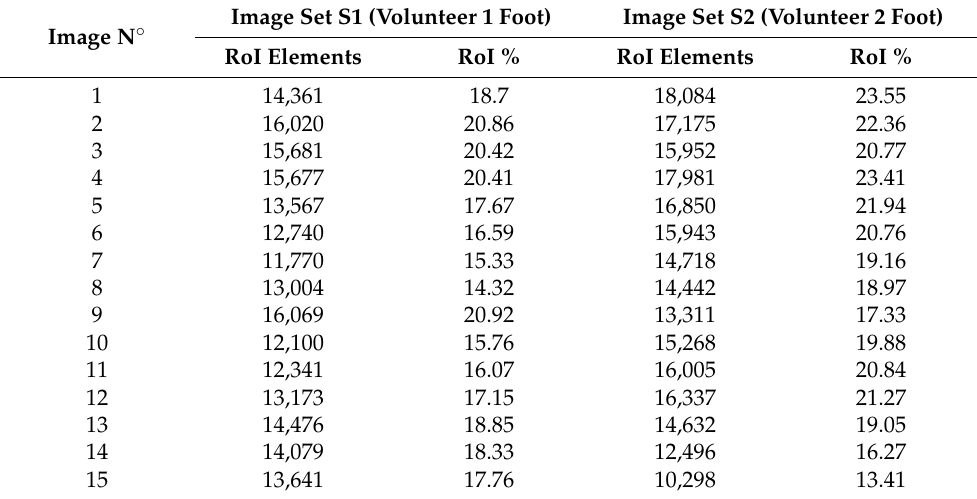
Table 6. RoI elements of the images collection S1 and S2. It is noticed that not all regions of interest have a constant number of elements.